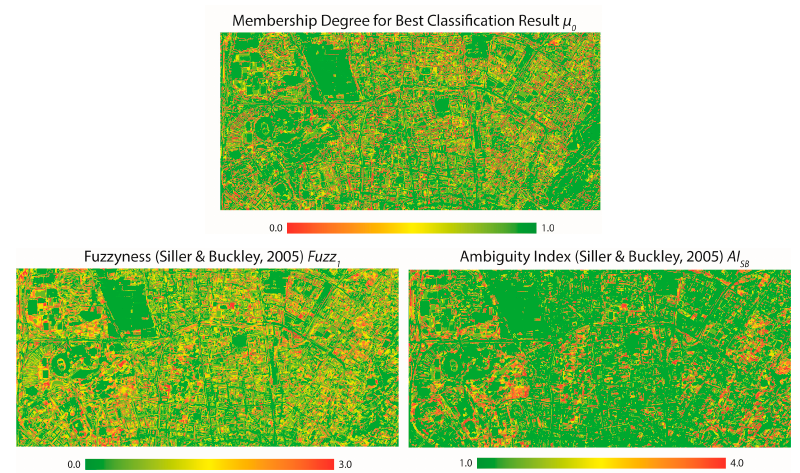
Figure 5. Objects’ membership degrees to the BCR ( µ 0 , upper ), measured values for fuzziness ( Fuzz 1 , lower left ) and ambiguity ( AI SB , lower right ) after segmentation and initial fuzzy classification ( L -Classes) of WV-2 scene of Munich as depicted in Figure 3.